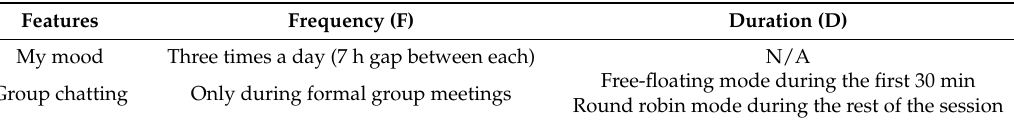
Table 5. Examples for specifying frequency and duration.